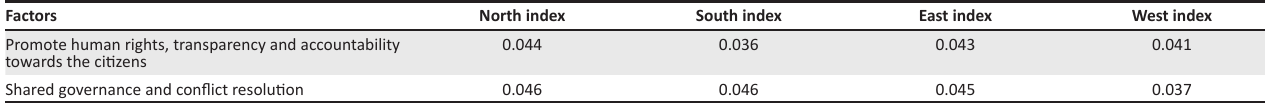
TABLE 6: Correlation matrix for promoting human rights, transparency and accountability, and shared governance and conflict resolution Factors